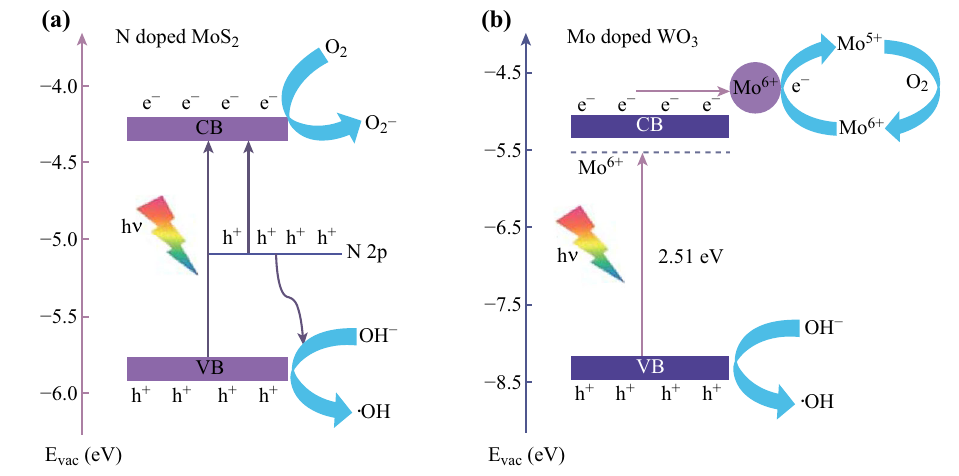
Fig. 6 Influence of elemental doping of a nonmetal element (N-doped MoS 2 nanosheets) and b metal element (Mo doped WO 3 nanosheets) toward the band structure. Reproduced with permission from Ref. [117,